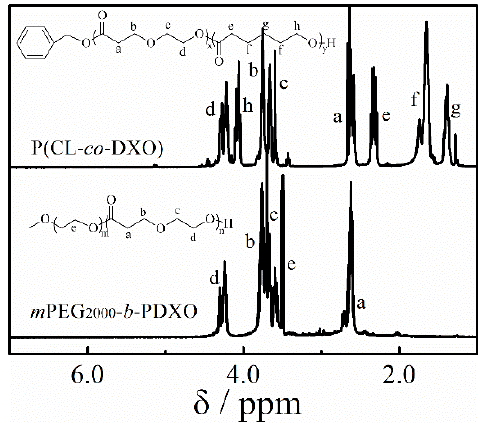
Figure 5. 1 H NMR spectra of P(CL- co -DXO) and m PEG 2000 - b -PDXO copolymers with t -BuP 4 as a catalyst.